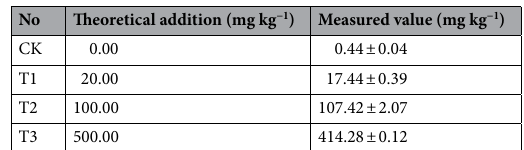
(TCA) solution and centrifuged (20 min, 6000 rpm). The supernatant (2 mL) was added to 0.67% thiobarbitu- ric acid (TBA) and heated (100 °C, 15 min), quickly cooled in an ice-cold water bathtub, and then centrifuged (10 min, 6000 rpm). Absorbance was determined at 450 nm, 532 nm, and 600 nm, and MDA content was cal- culated via the difference between both absorbance values 28 . Low molecular weight organic acids (LMWOAs) content analysis. The stipes of A. bisporus sam- ples stored at − 20 °C were taken for determination of LMWOAs content. About 0.5 g sample was homogenized with 5.00 mL 0.1% H 3 PO 4 and ultrasonic for 30 min and incubated at 75 °C for 15 min. After centrifugation (20 min, 13,000 rpm), the supernatant was passed through a 0.22 μm filter membrane for further high-perfor- mance liquid chromatography (HPLC) analysis 29 .